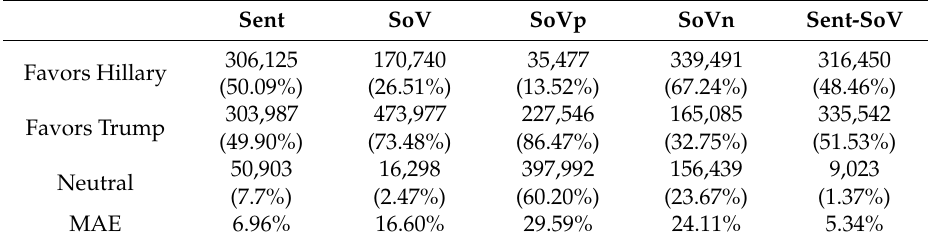
Table 4. Performance comparison for di ff erent ways of opinion score calculation.